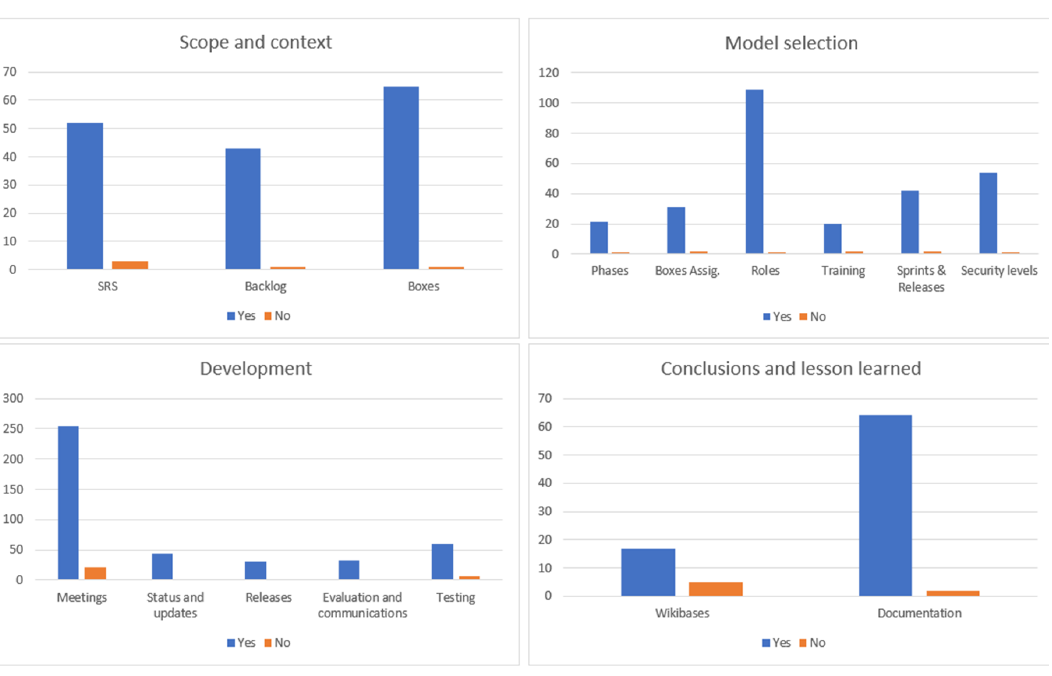
Figure 4. Survey results.